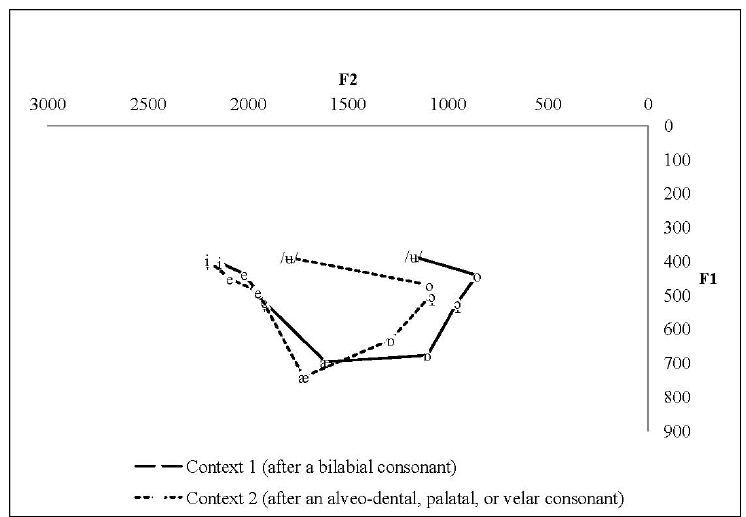
Figure 1. Praia da Salema: vowels according to context (Hz, mean